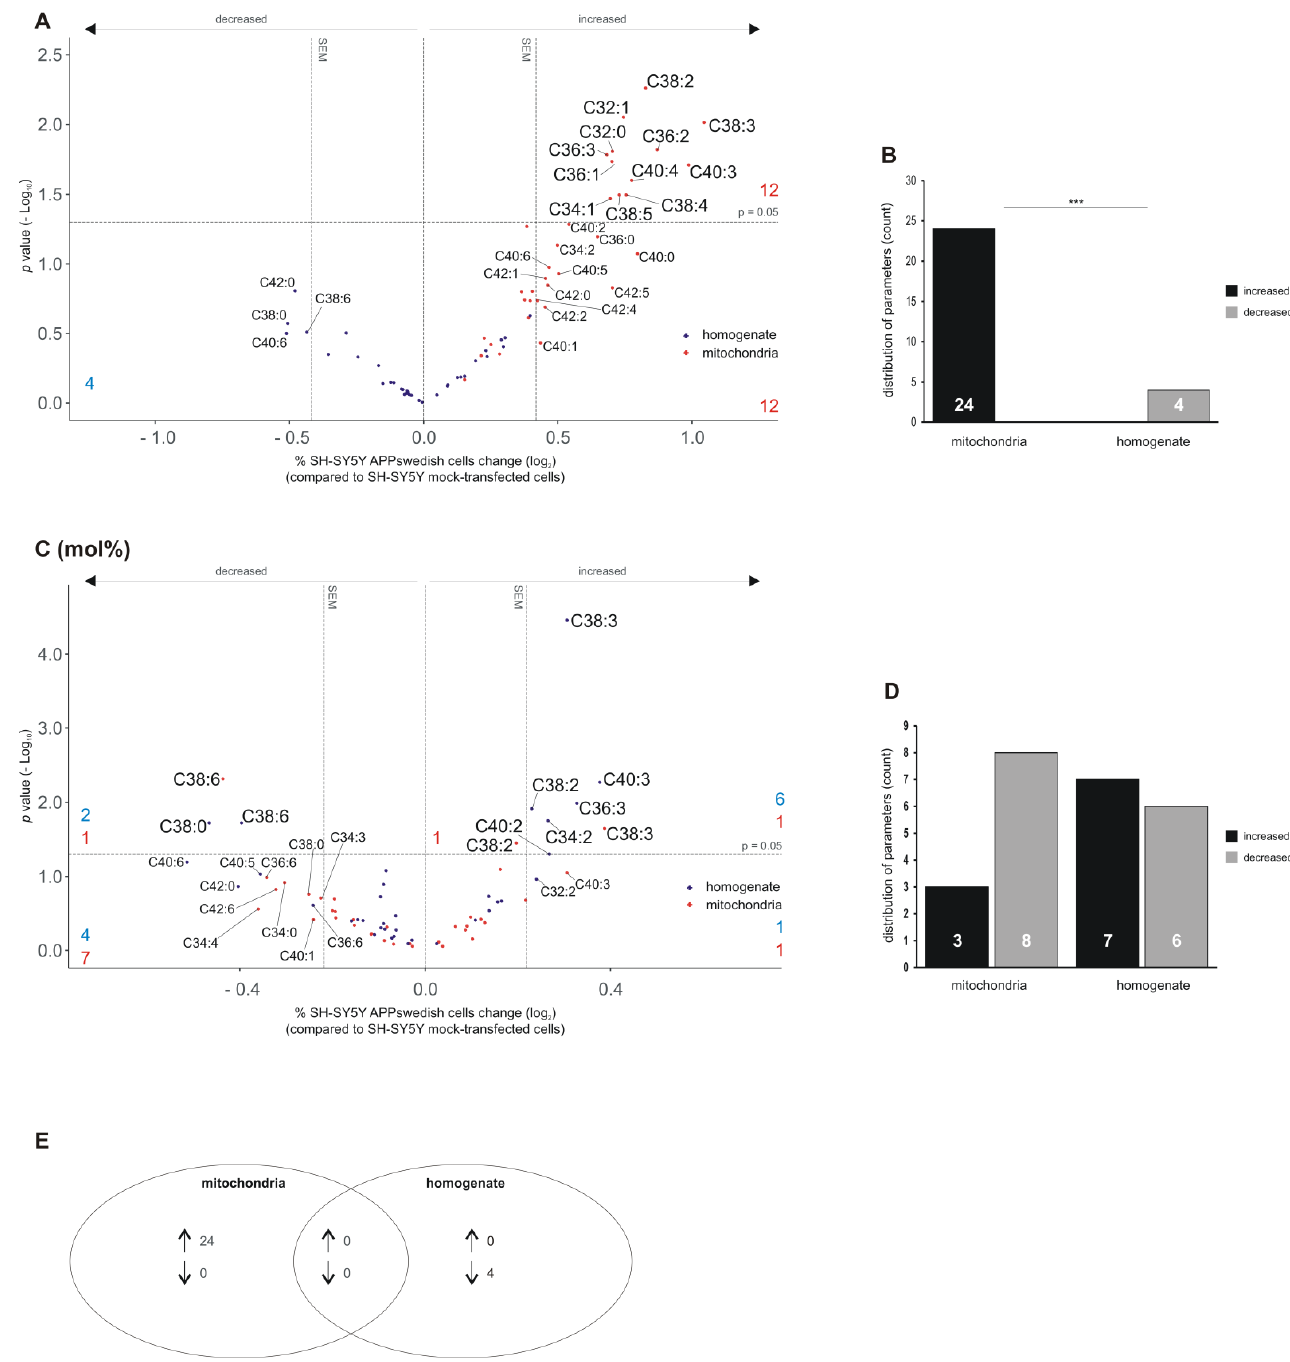
Figure 6. Changed phosphatidylethanolamine (PEaa) levels in homogenates and mitochondria of SH-SY5Y APPswedish cells in comparison to mock-transfected SH-SY5Y cells, respectively. ( A , B ) The fold changes of single PEaa species in ho- mogenates and mitochondria are shown as volcano plots and the corresponding distribution analysis is shown in a bar chart on the right. ( C , D ) The effects of single PEaa species independent of PEaa lipid class effect are presented as appro- priate volcano plot and bar chart. Vertical dashed lines next to 0.0 represent the average SEM and the horizontal dashed line marks p = 0.05 in volcano plots. Statistical significance was calculated using Fisher’s exact test with *** p ≤ 0.001. ( E ) Venn diagram showing the number of exclusively changed as well as overlapping PEaa species in mitochondria and ho- mogenates in SH-SY5Y APPswedish cells compared to mock-transfected cells. Arrows indicate decreasing ( ↓ ) or increasing ( ↑ ) effects.